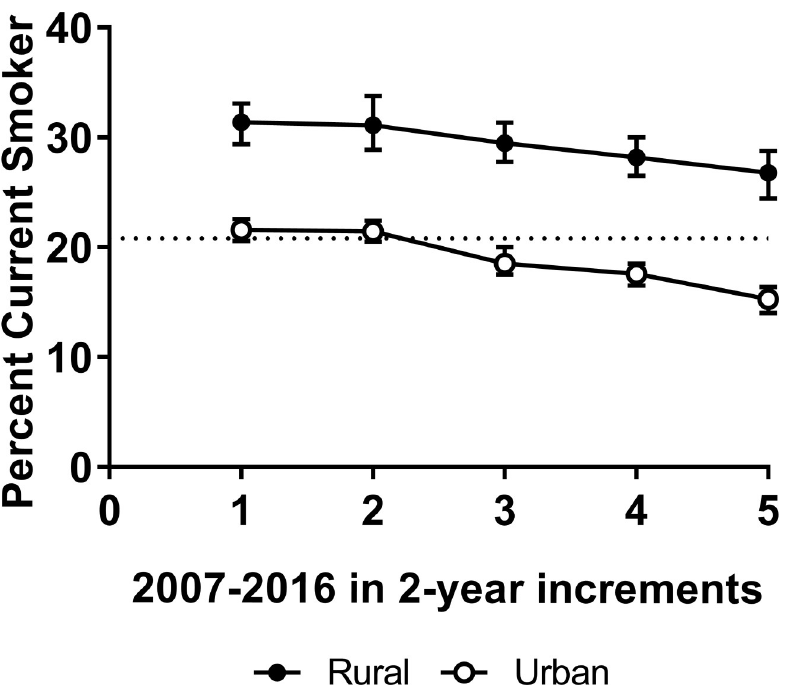
Fig 1. Current cigarette smoking prevalence among rural versus urban women in 2-year increments with 95% confidence bars. Estimates are weighted to reflect the U.S. population during the years 2007–2016. https://doi.org/10.1371/journal.pone.0207818.g001 compared to non-pregnant women decreased by 42% (AOR = .58, [.53 –.63]), suggesting greater pregnancy-related quitting among urban women. Adjusted odds of smoking in the overall sample also differed significantly across each of the selected covariates (see Table 2).